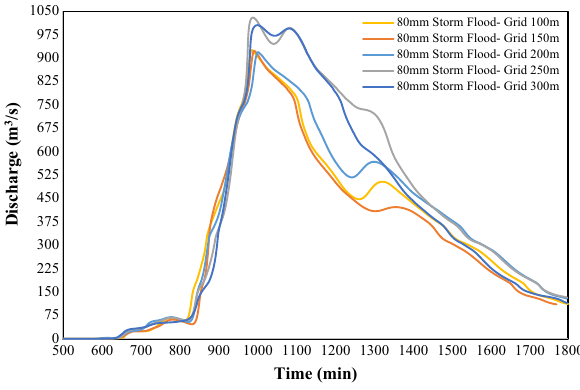
Fig. 23 Flood properties of calibrated GSSHA base model for a 24-h, 80 mm storm flood compared to hydrographs corresponding to GSSHA models with cell sizes of 100–300 m